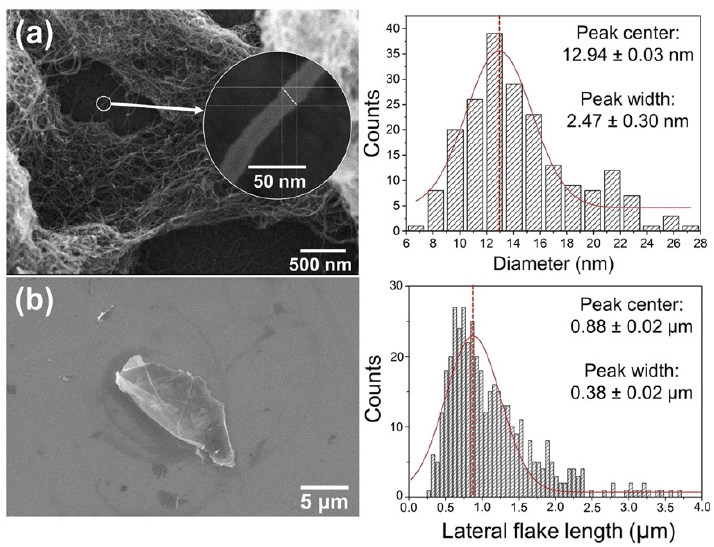
Figure 2. ( a ) FE-SEM image of a CNT bundle and their respective diameter size distribution; ( b ) SEM image of GNPs and their respective lateral size distribution.